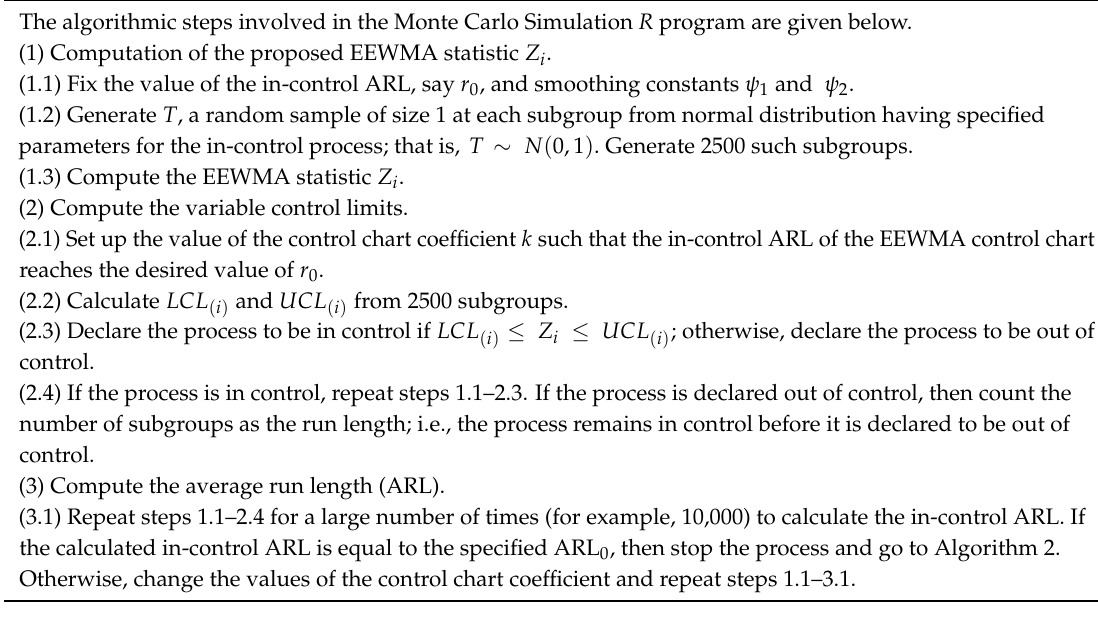
Algorithm 2: Monte Carlo Simulation R Program for shifted process of an EEWMA control chart in which the mean is shifted from µ 0 to µ 1 , where µ 1 = µ 0 + c σ The algorithmic steps involved in the Monte Carlo Simulation R program are given